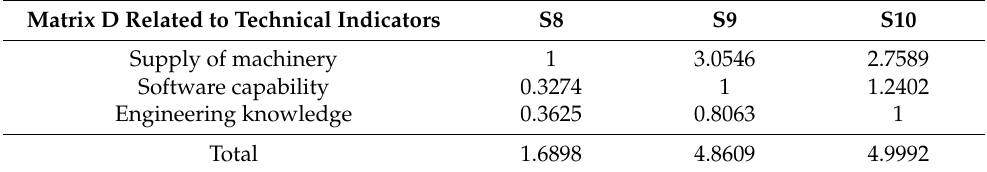
Table 8. Pairwise comparison matrix related to technical indicators.